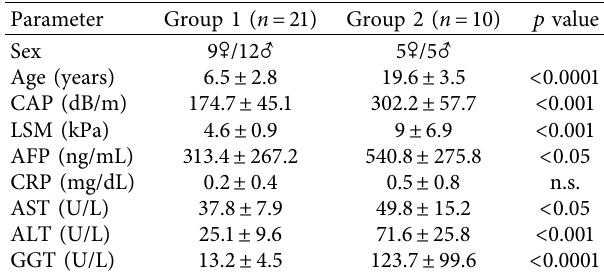
Table 1: Patients’